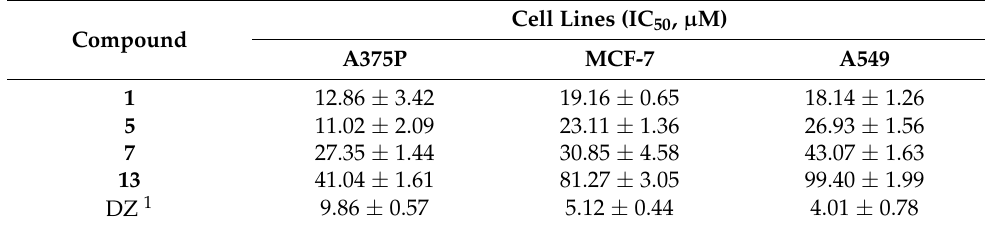
Table 1. Cytotoxic activities of compounds against cancer cell